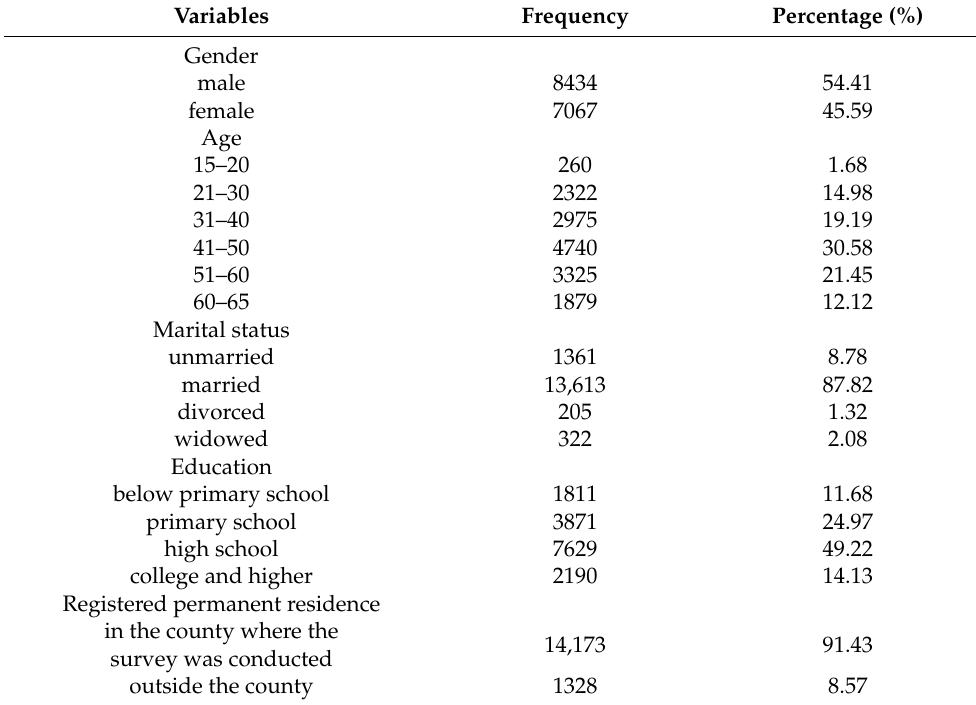
Table 1. Demographic characteristics of the